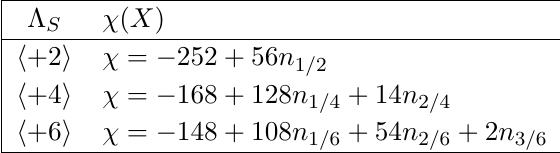
Table 2 . The Euler number (cid:31) in terms of the low-energy BPS indices n (cid:13) . n less than (cid:0) 2, and all the rest are